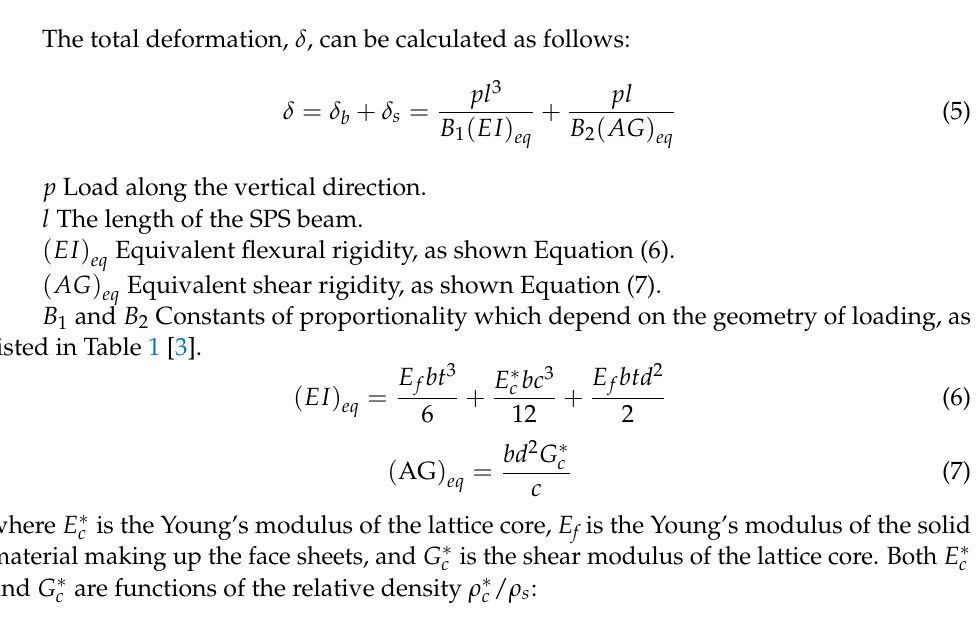
Figure 2. SPS under a three-point bending load.